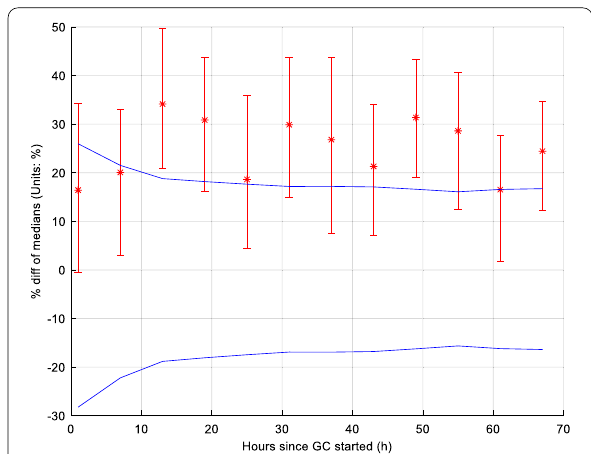
Fig. 4 Equivalence testing on insulin sensitivity for each 6 h block. The blue lines give equivalence range for typical 9.4% BG measurement error. The 95% CI (bars) bootstrap intervals cross, or are outside, the equivalence range, indicating these 6-h blocks are not equivalent